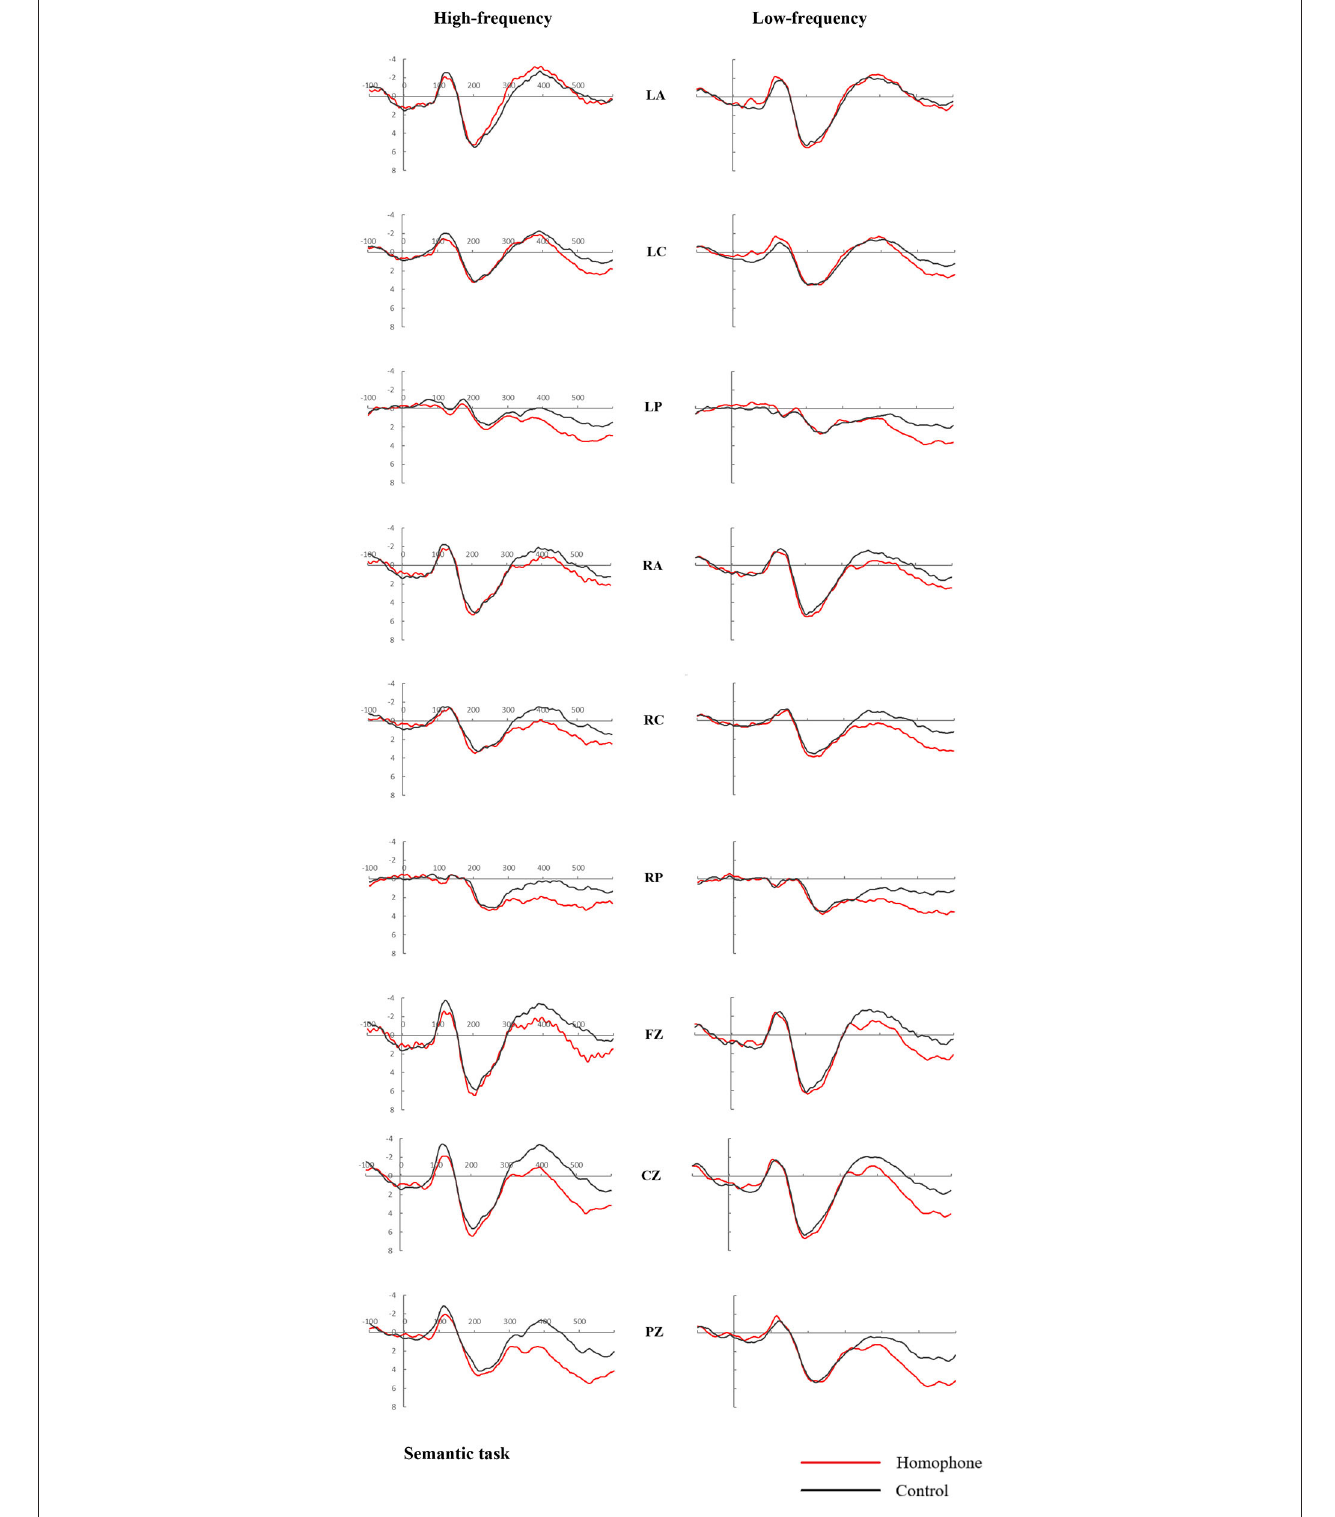
FIGURE 3 | Grand mean event-related potentials in response to target words, from representative electrodes (LA, LC, LP, RA, RC, RP, Fz, Cz, and Pz), for homophonic and control pairs in the semantic task.